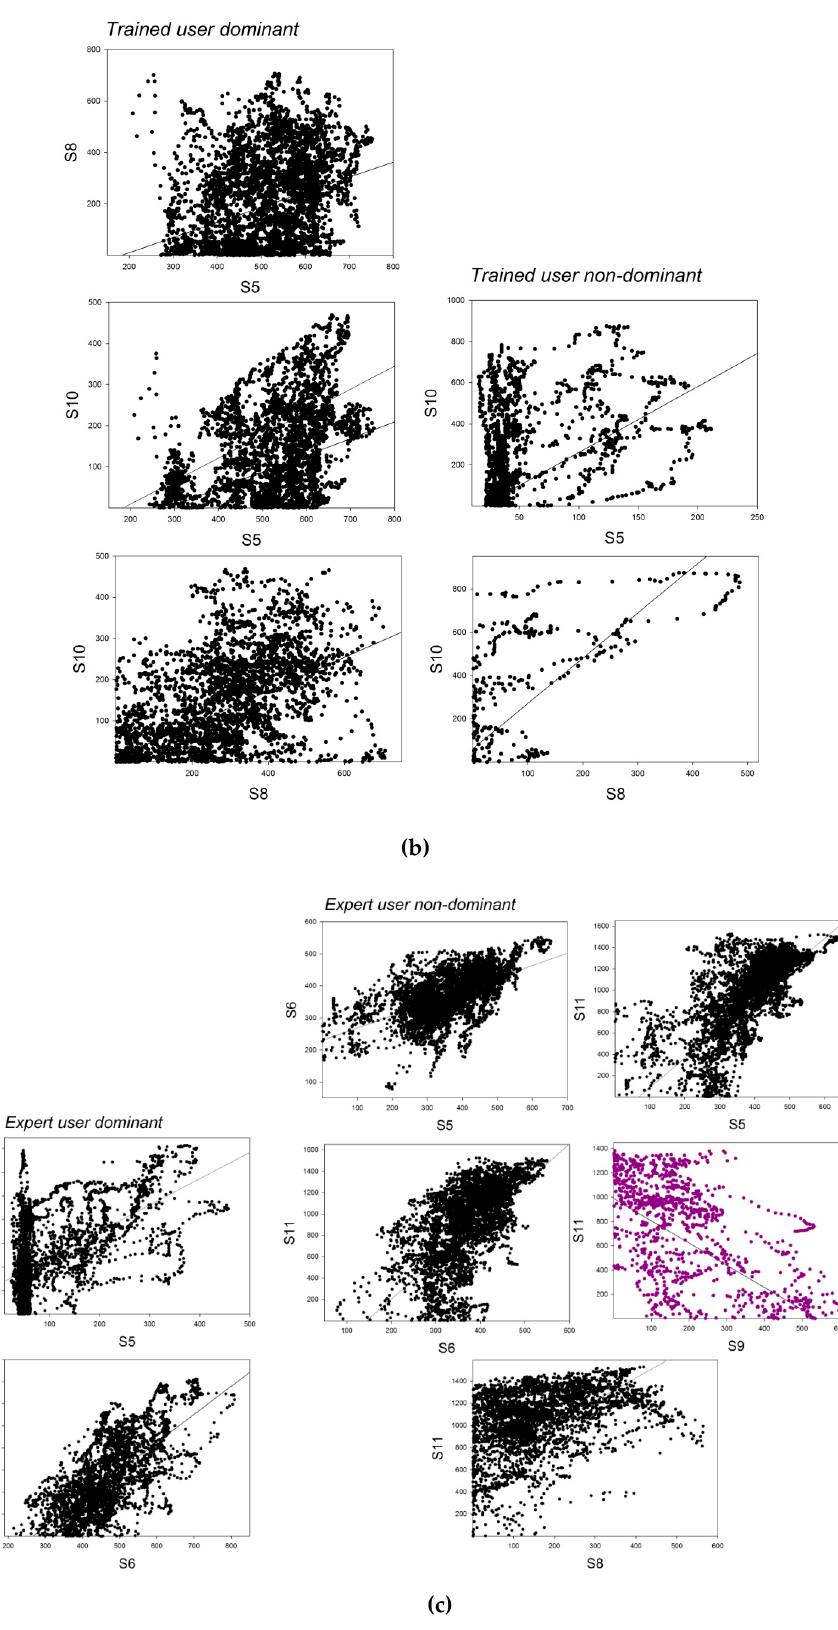
Figure 7. Graphic representations of significant positive or negative sensor correlations (Pearson’s product moment) between sensor signals in the dominant and / or non-dominant hands of the novice ( a ), the trained user ( b ), and the expert ( c